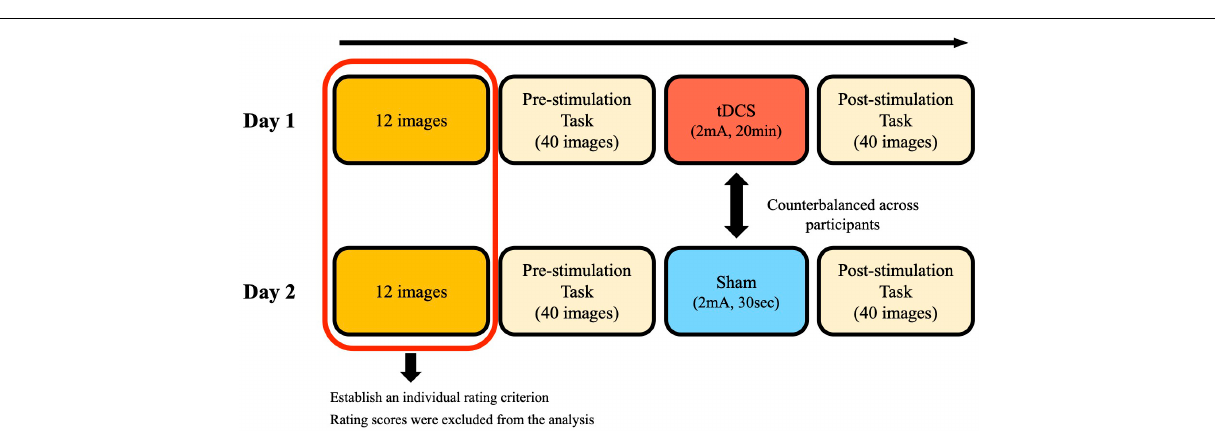
FIGURE 3 | Experimental design of Experiments 2, 3, and 4. By rating 12 images, participants established an individual rating criterion. They were told to rate 40 images in the pre-stimulation task and the post-stimulation task in accordance with the established